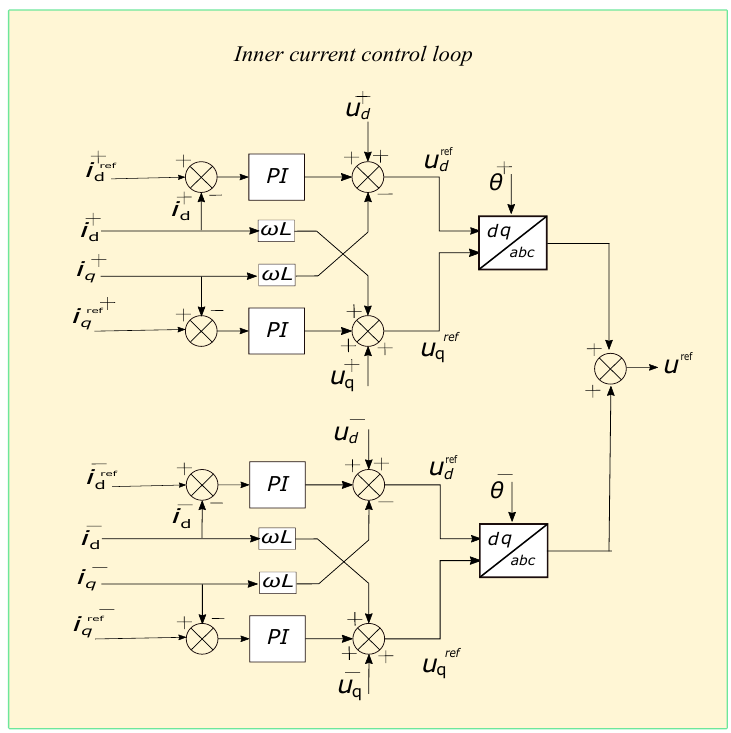
Figure 10. MMC DSRF inner current control